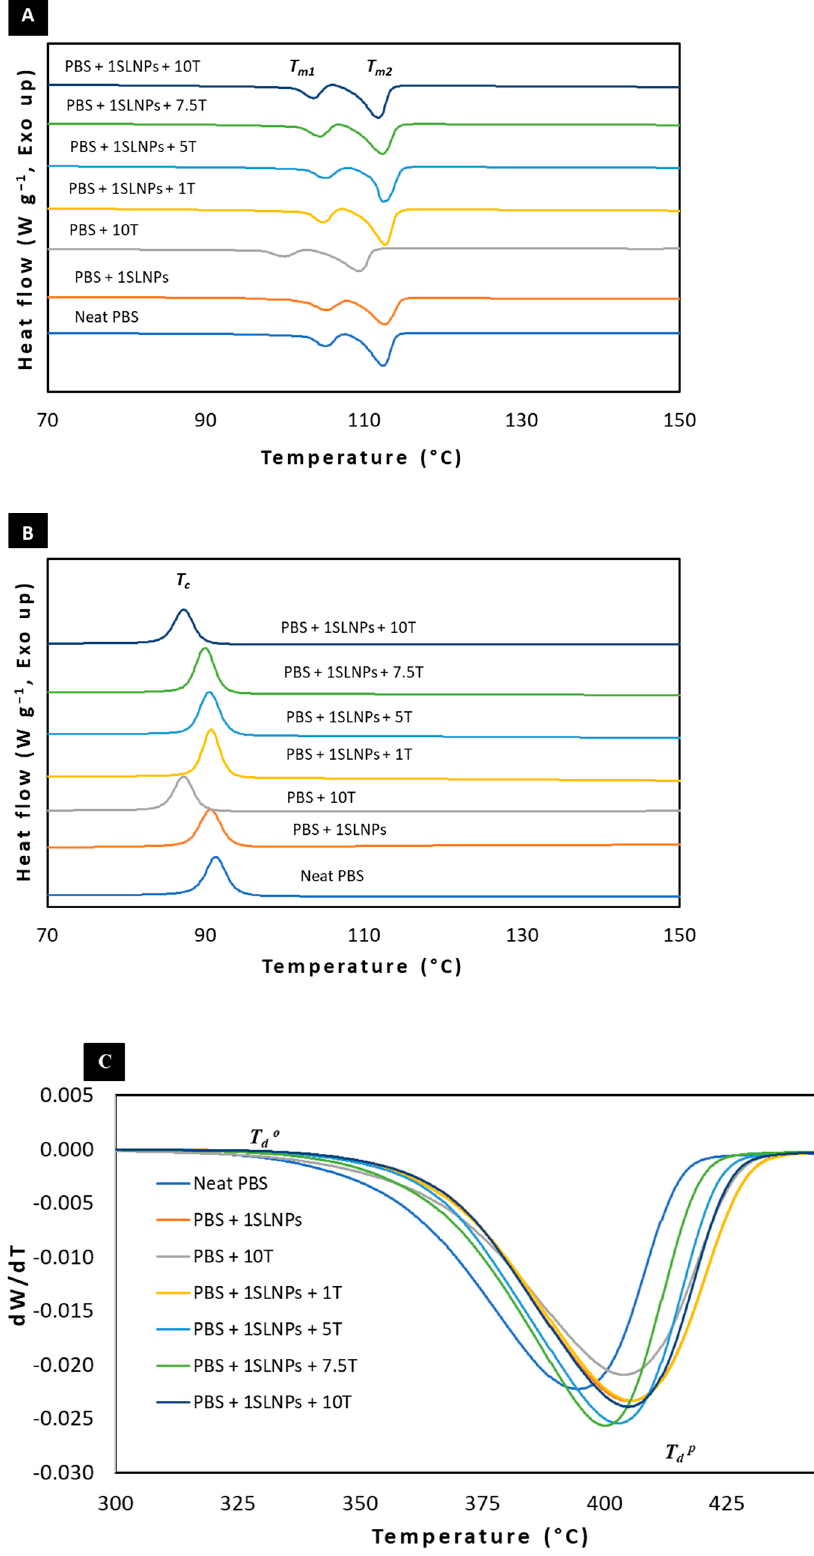
Figure 4. DSC thermograms of neat PBS and PBS composite films under nitrogen atmosphere—( A ) second heating scan melting peaks and ( B ) crystallization peak; ( C ) derivative thermogravimetry of neat PBS and PBS composite films showing the onset and peak of thermal decomposition using